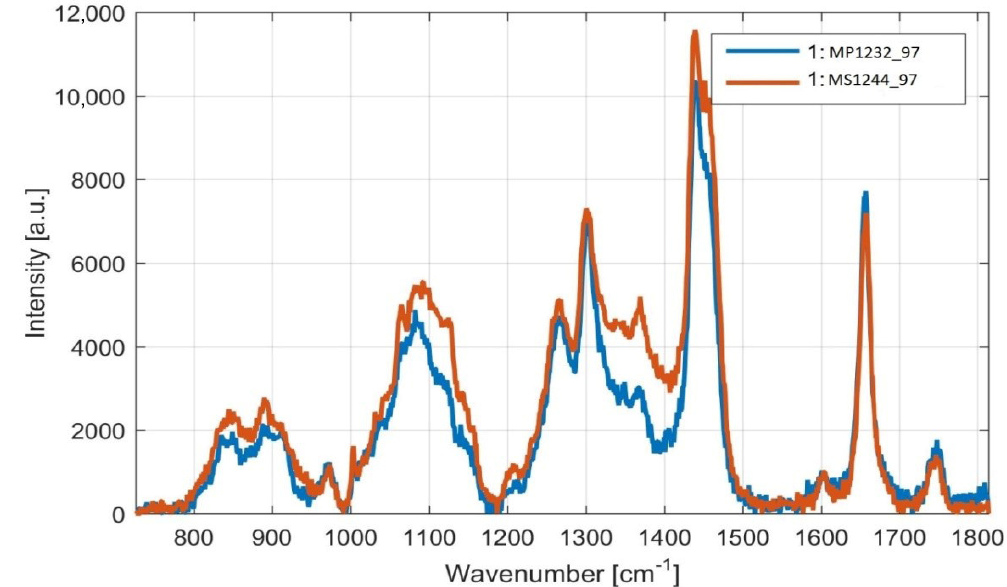
Figure 12. Raman scattering spectrum of intracellular lipids of the yeasts M. sinensis and M. pulcherrima on a medium of the same composition. Legend: Metschnikowia pulcherrima 1232 cultivated on medium with C/N ratio 97 (MP1232_97, blue trace) and Metschnikowia sinensis (MS1244_97, red trace).